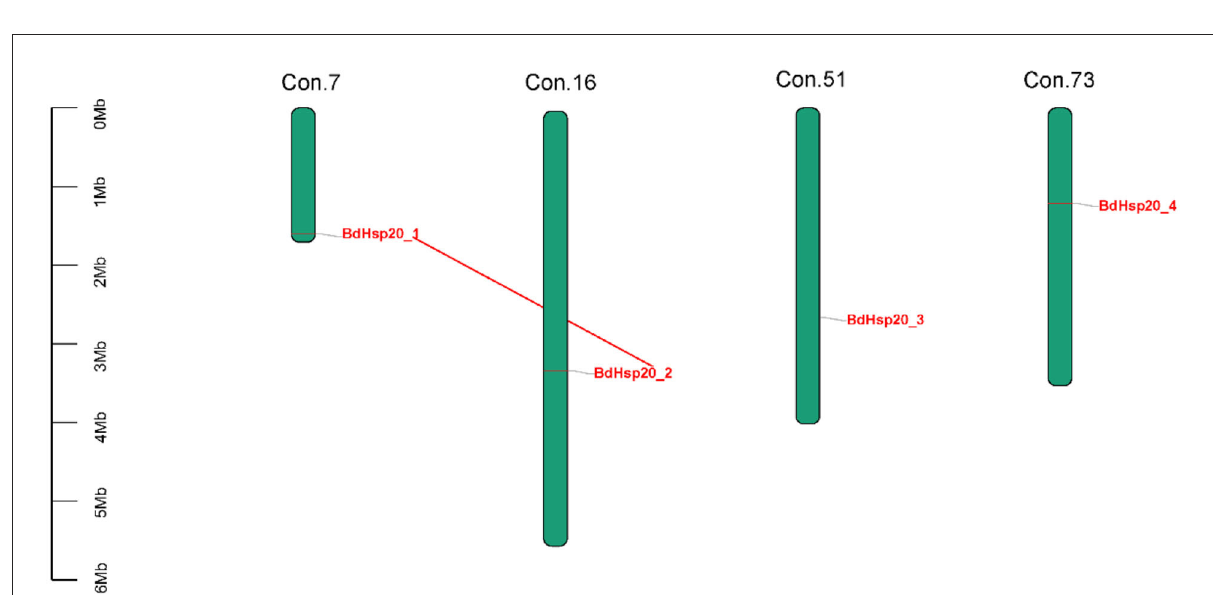
FIGURE4 Distribution of BdHsp20 gene family members on the Botryosphaeria dothidea contigs. Two genes linked with a red line represent a paralogous gene pair.